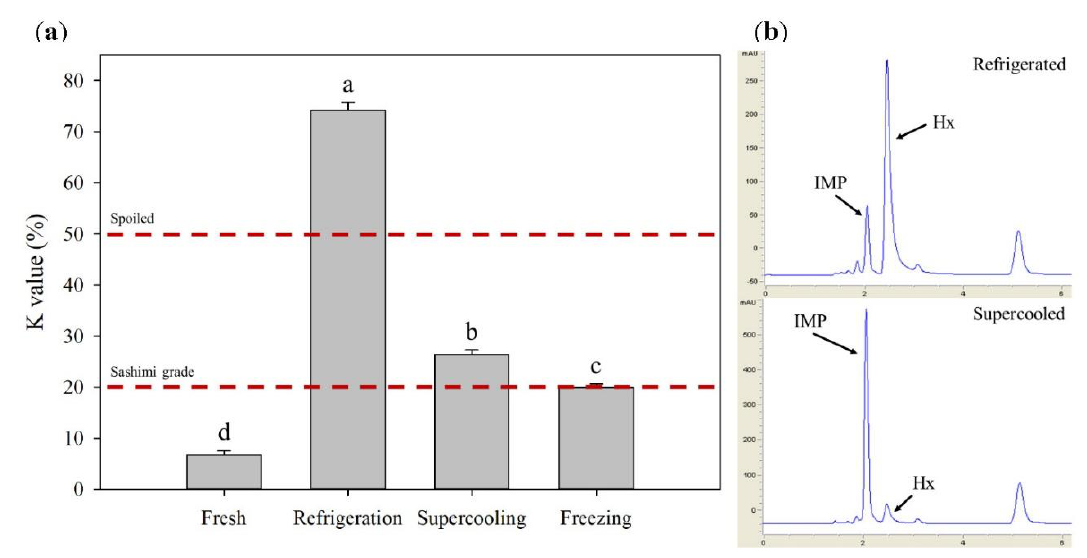
Figure 6. ( a ) K-values of sashimi-grade ahi tuna (80 g) after 8 days of respective treatments. K-value cutoffs for spoiled (50%) and (20%) sashimi grade are given based on previous research [26]. Different letters indicate significant differences ( p < 0.05) between treatments. ( b ) HPLC (High Performance Liquid Chromatography) chromatographs of tuna samples after refrigeration (8 days) (top) and PEF- and OMF-based supercooling (8 days) (bottom). Inosine5′-monophosphate (IMP) and hypoxanthine (Hx) peaks are indicated.